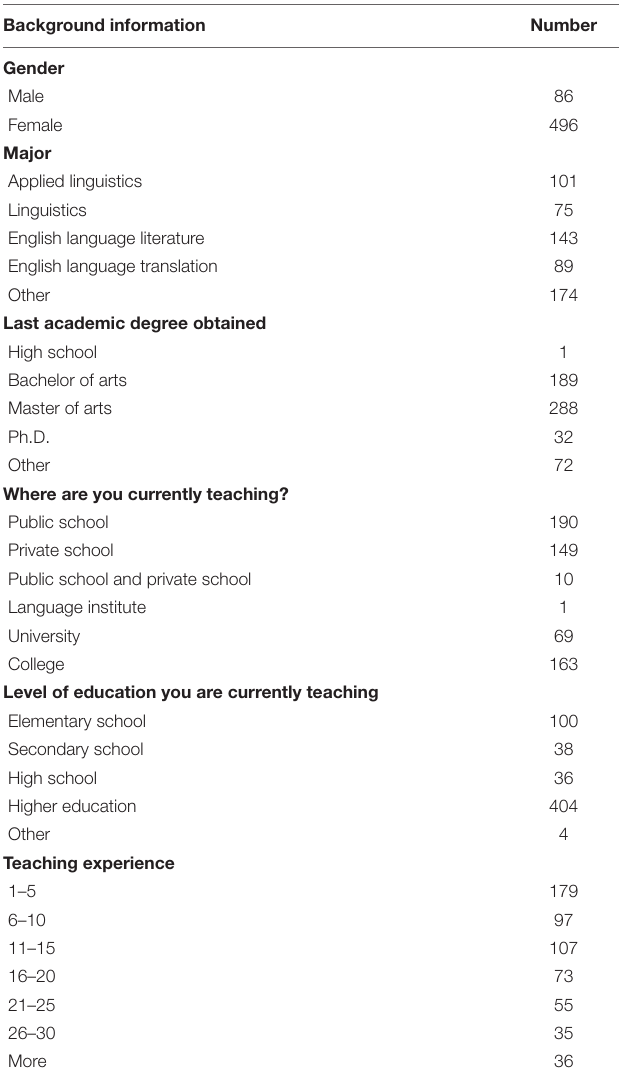
TABLE 1 | Participants’ demographic